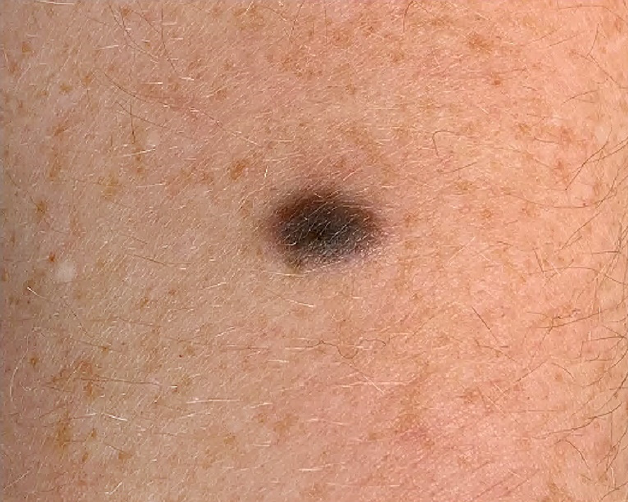
Figure 1. Deep penetrating nevi present as small, symmetrical, sharply circumscribed, pigmented papules or nodules.